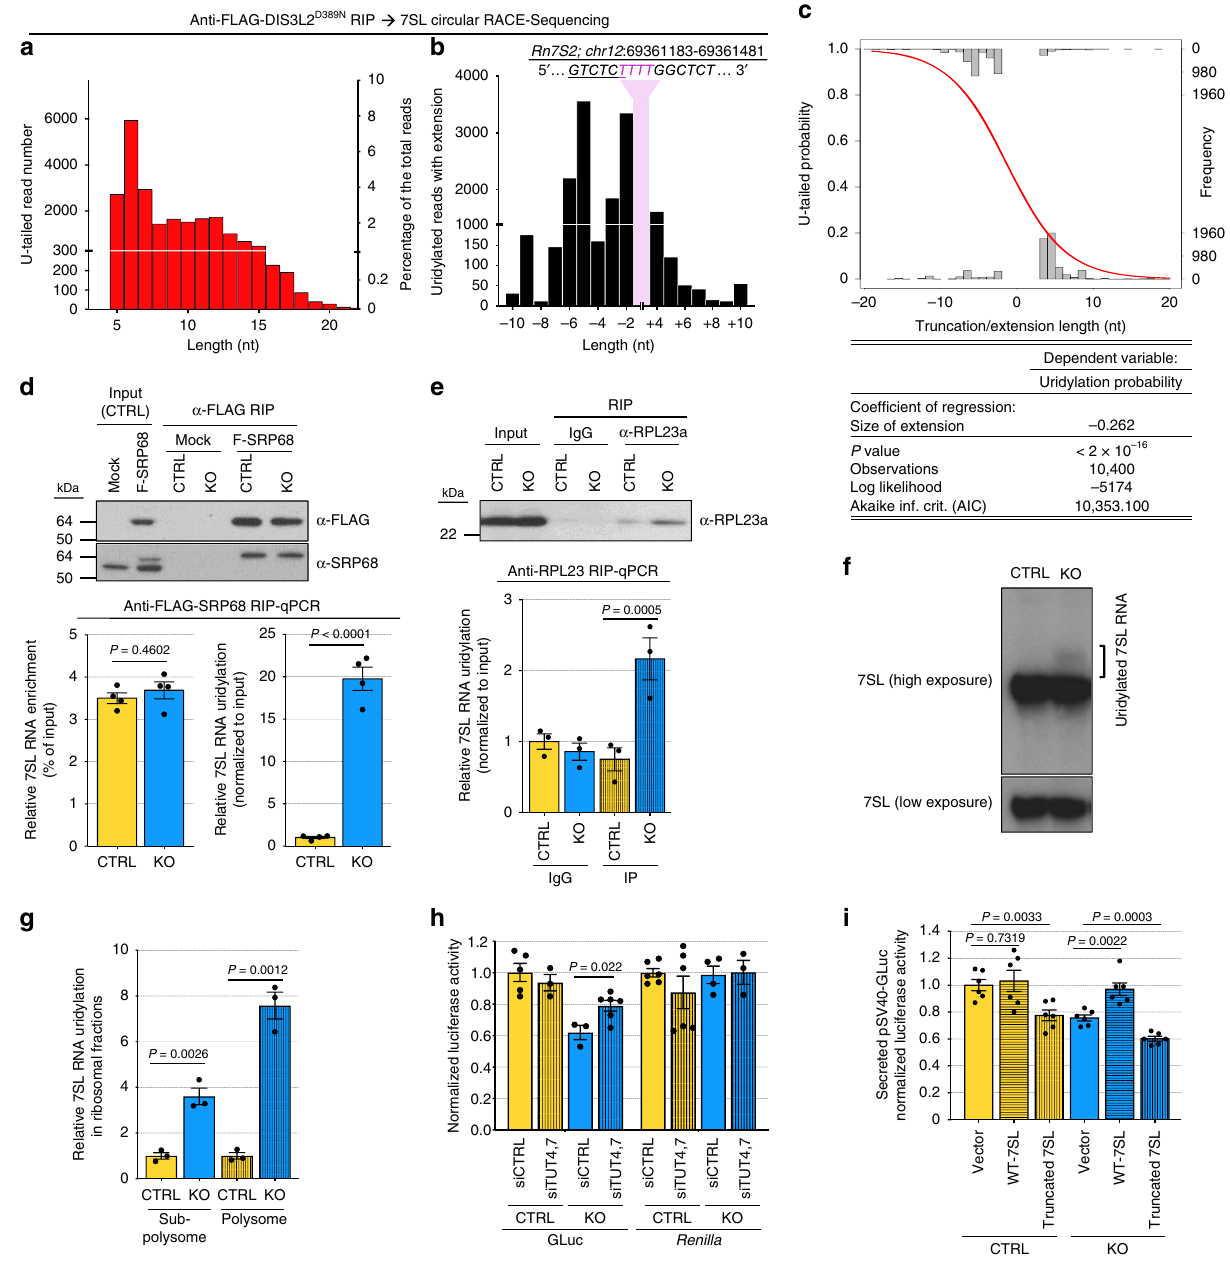
Fig. 3 DIS3L2-targeted quality control of 7SL. a cRACE analysis of DIS3L2-bound 7SL RNAs in knockout cells revealing extensive 3 ′ -end uridylation. b cRACE analysis of DIS3L2-bound 7SL RNAs in respect to its canonical 3 ′ end (underlined). Note that most of the reads end before the canonical end. Nucleotides from mature 7SL RNA or genomic extensions that are transcribed into uridine are marked in magenta and excluded from the analysis. c Logistic regression analysis of U-tailed occurrence in respect to 7SL RNA truncation or genomic extension. d Co-precipitation of 7SL RNA with ectopically expressed FLAG-SRP68 (F-SRP68) protein analyzed by qRT-PCR. Upper panel showing Western blot. Lower left panel: Equal enrichment of 7SL RNA in FLAG-SRP68 precipitates from knockout and control samples; lower right panel: relative uridylation of 7SL RNA in corresponding samples. Bars represent mean±SEM and P values (unpaired two-tailed Student ’ s t test, 0.95 con fi dence intervals; n = 4 independent experiments). e Enrichment of uridylated 7SL RNA in RPL23a-IP samples in DIS3L2 knockout samples. Upper panel showing Western blot and lower panel showing qRT-PCR. Bars representing mean±SEM and P values (unpaired two-tailed Student ’ s t test, 0.95 con fi dence intervals; n = 3 independent experiments) are indicated. f Northern blot analysis of 7SL RNA expression in total RNA samples from control and DIS3L2 knockout cells. Slow migrating uridylated 7SL RNA species are marked. This experiment was repeated thrice independently with similar results. g qRT-PCR analysis showing a signi fi cant accumulation of uridylated 7SL RNA in the subpolysome and specially polysome fraction of DIS3L2 knockout cells. Bars representing mean±SEM and P values (unpaired two-tailed Student ’ s t test, 0.95 con fi dence intervals; n = 3 independent experiments) are indicated. h Normalized activity of GLuc and Renilla (from TK vector) reporters in DIS3L2 knockout mESCs, and the effect of TUTases depletion on these two reporters. Bars represent mean±SEM. P values (unpaired two-tailed Student ’ s t test, 0.95 con fi dence intervals) are shown ( n = at least three independent experiments). KO represents DIS3L2 knockout mESCs and CTRL represents heterozygous control mESCs. i Normalized secreted luciferase activity following forced expression of full-length (WT) or truncated 7SL RNAs ( n = 6 independent experiments). Bars representing mean ±SEM and P values (unpaired two-tailed Student ’ s t test, 0.95 con fi dence intervals) are shown. Source data are provided as a Source data fi